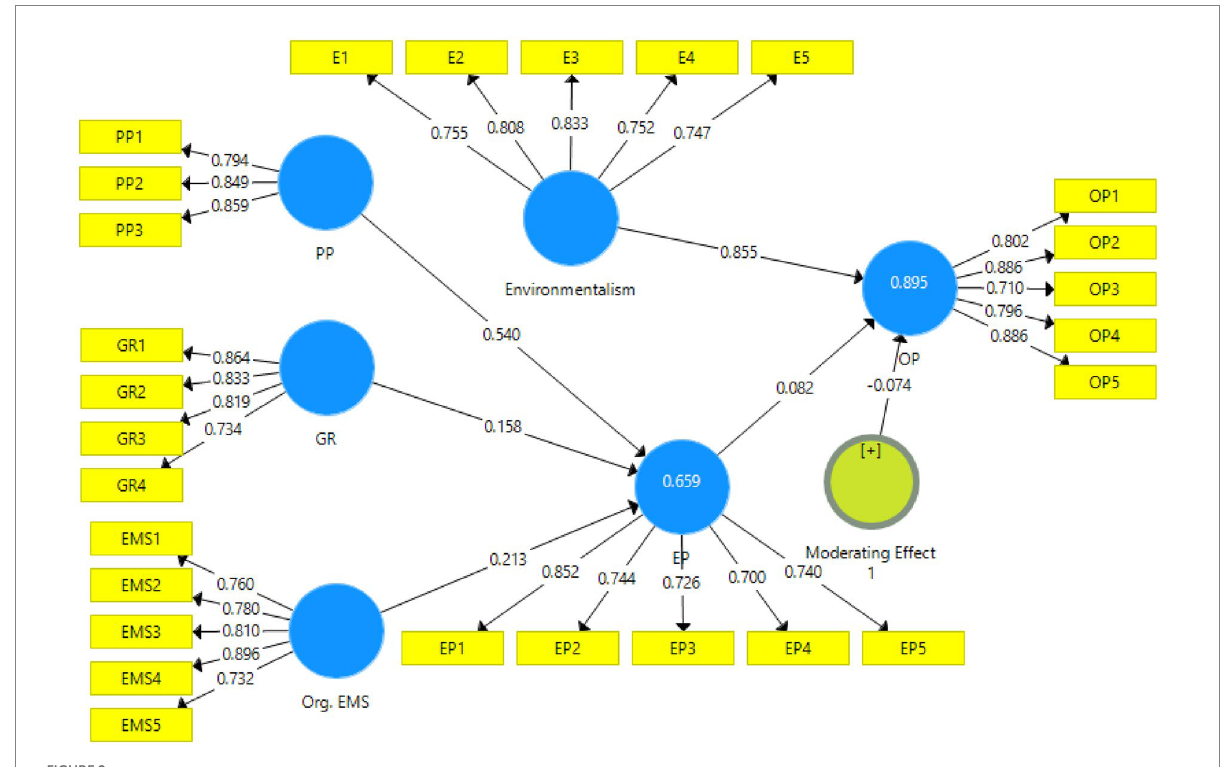
FIGURE 2 PLS algorithm.